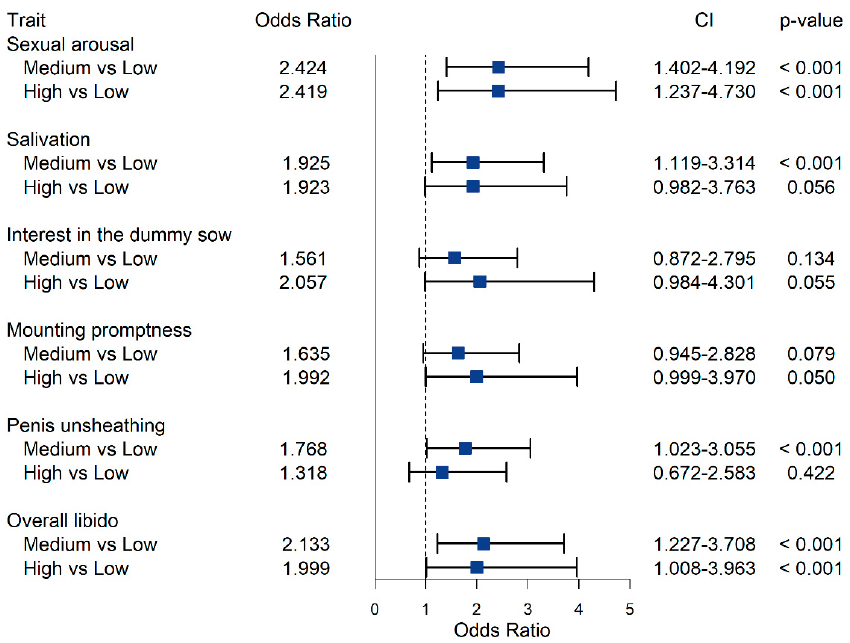
Figure 5. Odds ratio for the effect of average and high indole concentration in subcutaneous adipose tissue, compared to low indole concentration, on sexual behavior traits evaluated during the third training session. The dashed line corresponds to an odds ratio equal to 1.00.